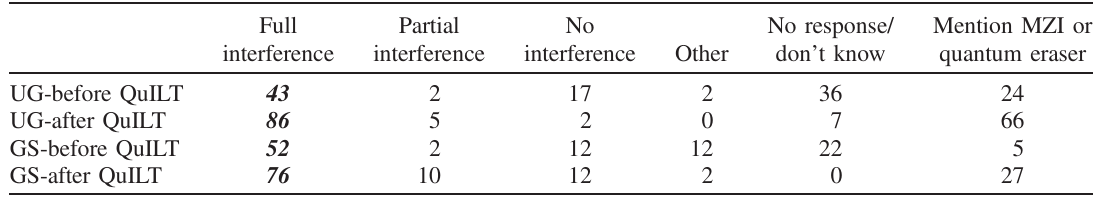
TABLE XI. Percentages of undergraduate (UG) and graduate students (GS) with different answers to Q5 (full interference, partial interference, no interference, other, and no response/ “ I don ’ t know ” ), including percentages